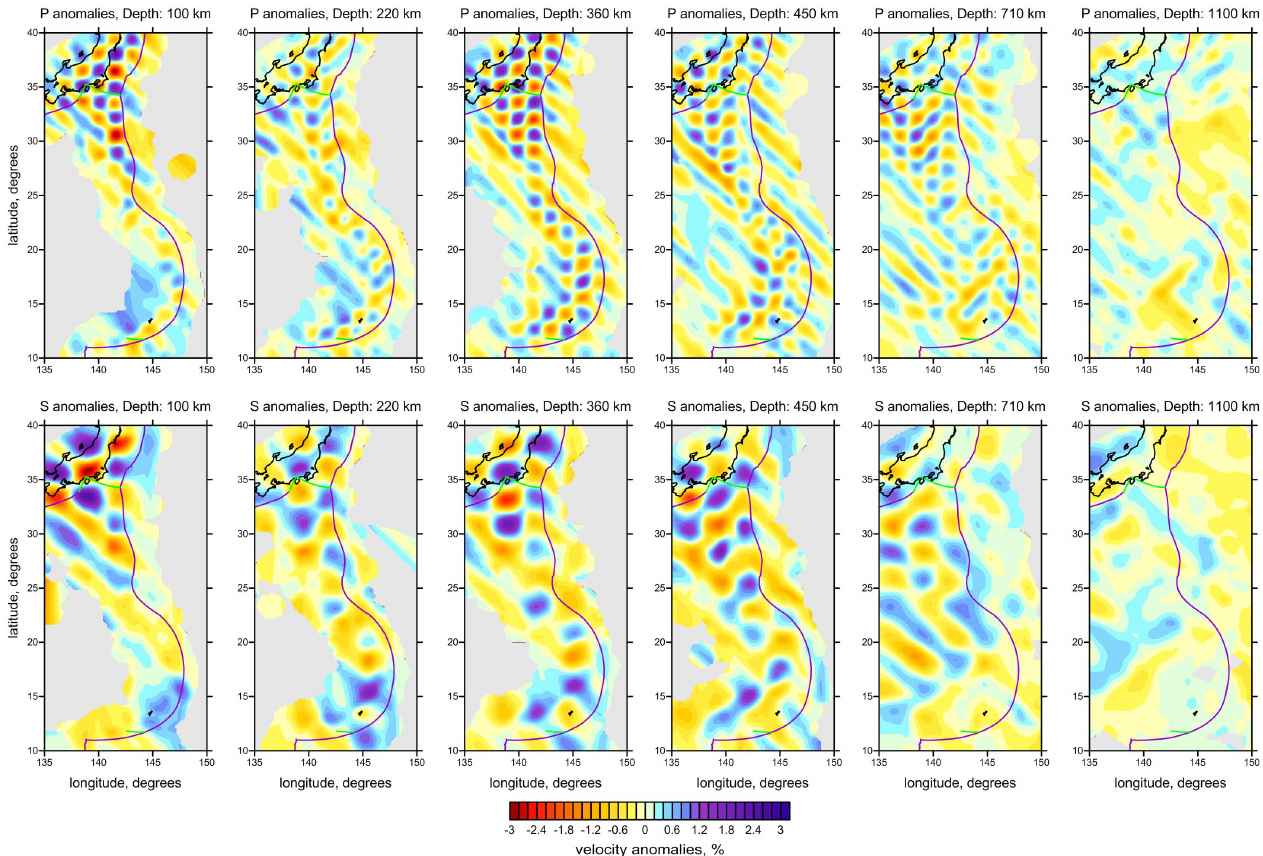
Fig. 7. Synthetic test “Checkerboard”. The distribution of P- and S-anomalies are shown at different depths. The sizes of synthetic anomalies are: 1 ◦ × 1 ◦ for the P-model with the distance between the anomalies of 0.5 ◦ and 2 ◦ × 1.5 ◦ for S-model with the distance between the anomalies of 1 ◦